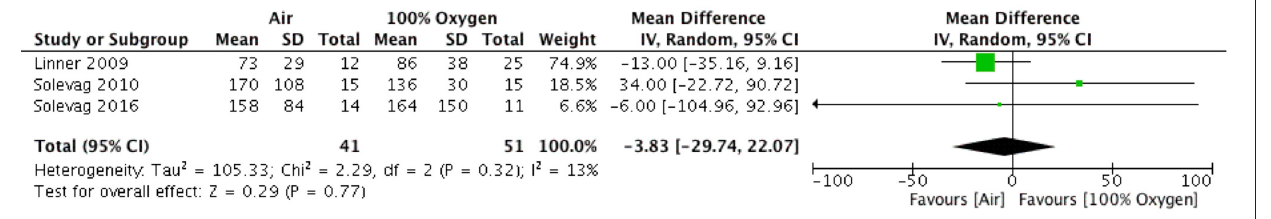
FIGURE 2 | Time to return of Spontaneous Circulation in piglets resuscitated with either Air or 100% oxygen during neonatal cardio-pulmonary